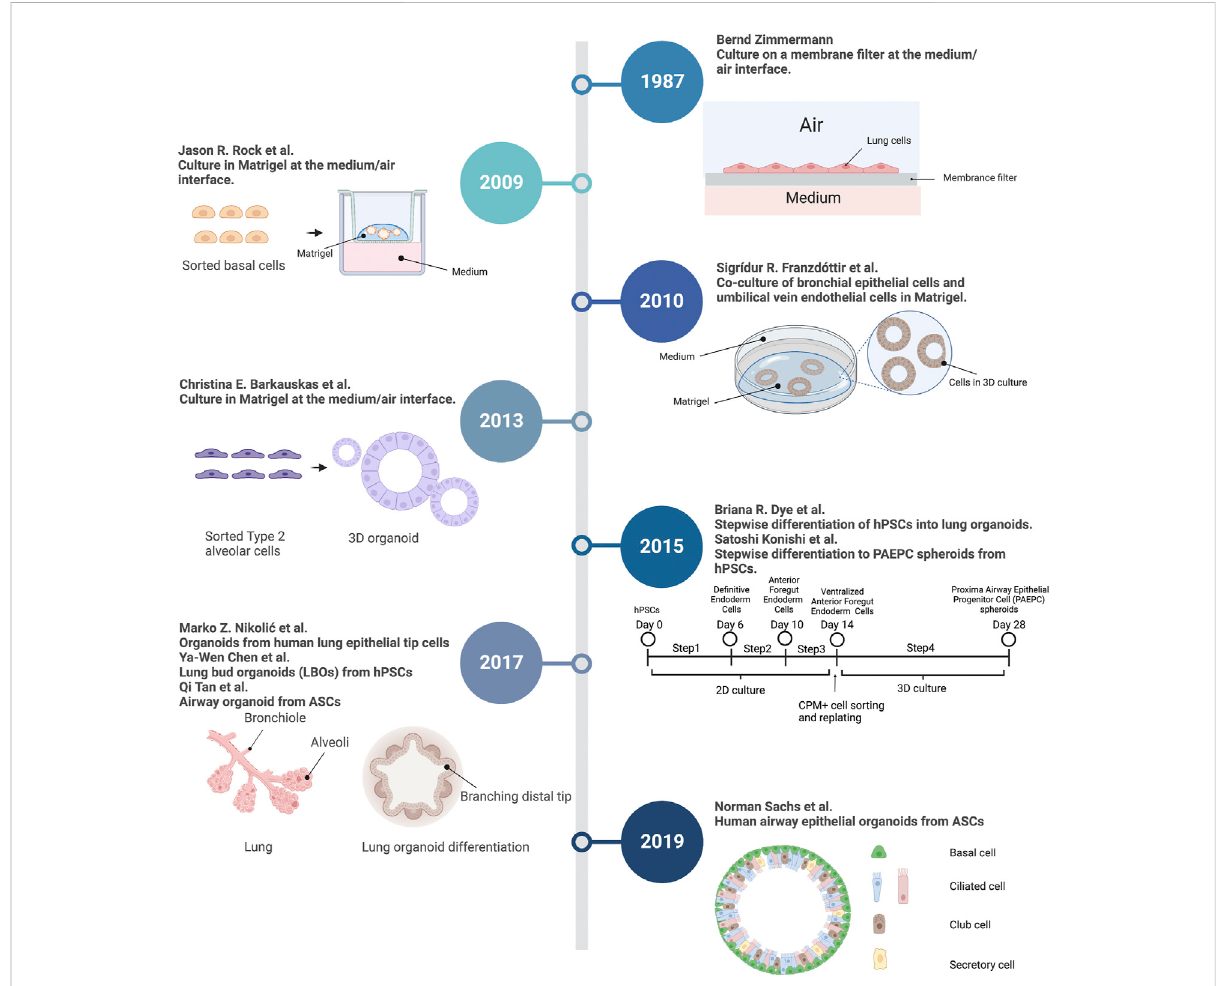
FIGURE 1 Timeline of techniques and experiments in lung organoid fi eld. A summary of key events in the history contributing to lung organoid methodology. 3D, 3-dimensional; hPSCs, human pluripotent stem cells; ASCs, Adult stem cells; PAEPC, proximal airway epithelial progenitor cells. Created with